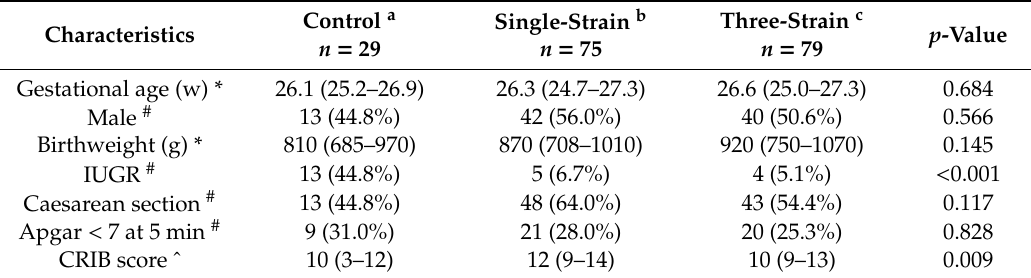
Table 1. Neonatal and maternal characteristics.